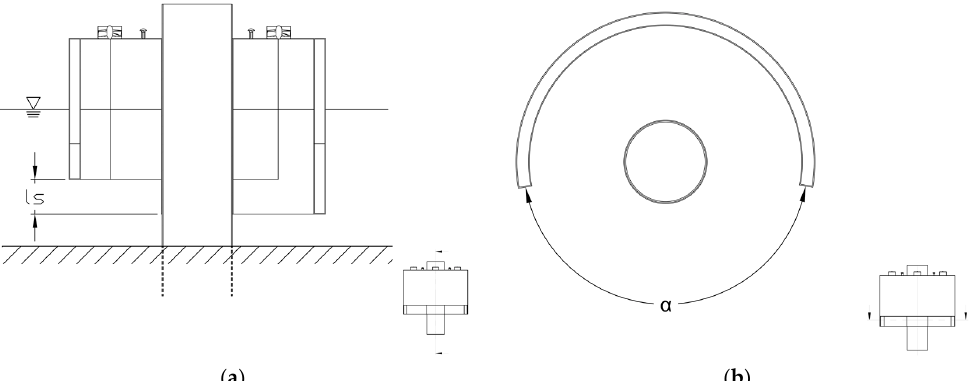
Figure 2. Schematic representation of the OWC skirt, its length ( l S ) and aperture angle ( α ): ( a ) cut view of the device with a vertical lateral plane; and ( b ) cut view of the device with a horizontal plane at the skirt level (partially reproduced from [48]).